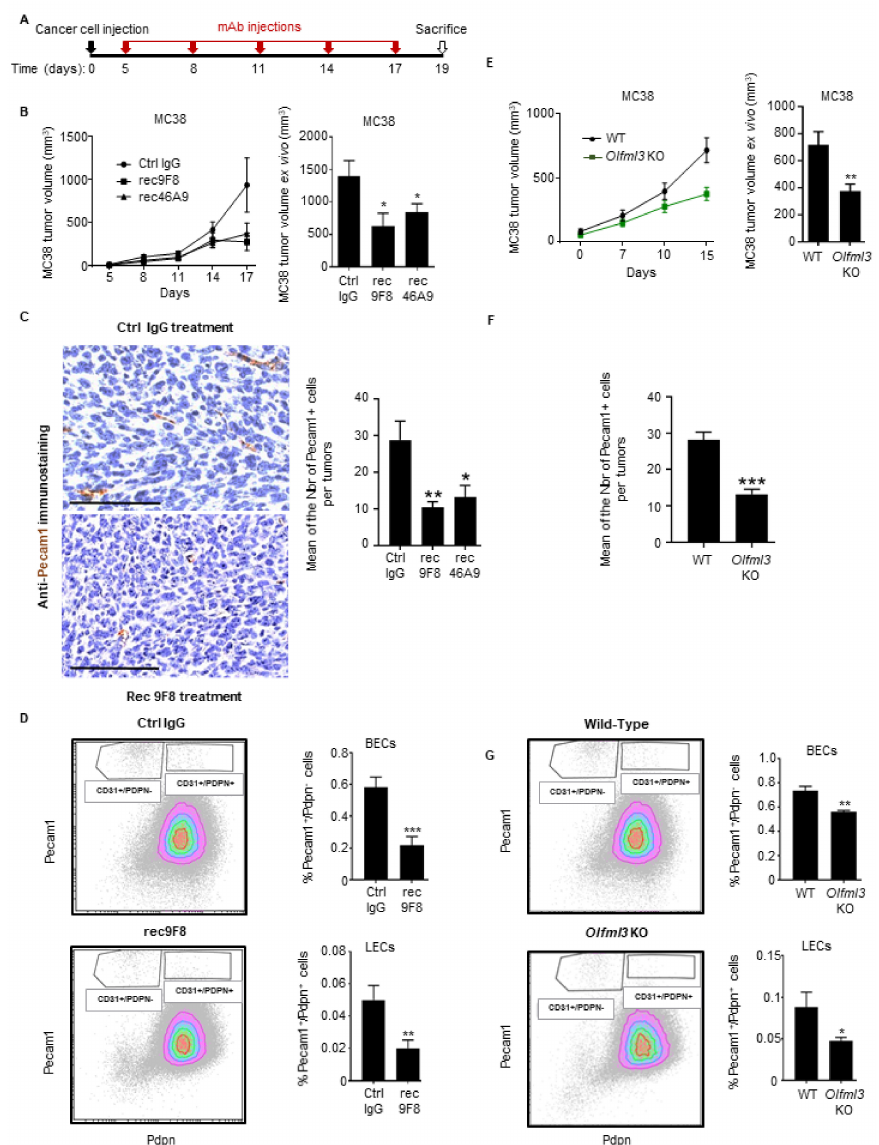
Figure 3. Expression of OLFML3 in inhibitory effects of anti-OLFML3 mAbs and Olfml3 gene deletion on CRC tumor growth and vascularization. ( A ) C57Bl6/J mice received a subcutaneous implant of MC38 tumor cells, followed by treatment with anti-OLFML3 or isotype control mAbs on days 0, 5, 8, 11, 14, and 17. ( B ) The volume of MC38 tumors in mice treated with rec9F8 ( n = 7), rec46A9 ( n = 7), or IgG2a isotype control mAb (Ctrl IgG, n = 8) was measured every 2–4 days (starting on day 3) using a caliper ( left ) or ex vivo after sacrifice on day 19 ( right ). Bars ( right ) represent the mean ± SEM; * p < 0.05. ( C ) Right, representative images (scale bar, 100 µ m), and left, quantification of Pecam1-positive events after Pecam1 immunostaining of tumor sections from ( B ). Results represent mean values ± SEM; * p < 0.05; ** p < 0.01. ( D ) Gating strategy used for flow cytometry analysis of CD45 − /CD31 + /PDPN − vascular endothelial cells and CD45 − /CD31 + /PDPN + lymphatic endothelial cells in single-cell suspensions derived from MC38 tumors from mice treated with rec9F8 or control IgG antibodies ( left ). Quantification of vascular CD45 − /CD31 + /PDPN − (middle) and lymphatic CD45 − /CD31 + /PDPN + ( right ) endothelial cells. ( E ) Growth curve (left) and ex vivo measurement of the volume ( right ) of MC38 tumors growing in wild-type (WT) ( n = 9) or Olfml3 knockout mice ( n = 14). Bars ( right ) represent the mean ± SEM; * p < 0.01. ( F ) Quantification of Pecam1- positive events after Pecam1 immunostaining of the tumor sections ( E ). Results represent the mean value ± SEM; * p < 0.05; ** p < 0.01. ( G ) Gating strategy used for flow cytometry analysis of CD45 − /CD31 + /PDPN − vascular endothelial cells and CD45 − /CD31 + /PDPN + lymphatic endothelial cells in MC38 tumor-derived single-cell suspensions from WT and Olfml3 knockout mice ( left ). Quantification of vascular CD45 − /CD31 + /PDPN − (middle) and lymphatic CD45 − /CD31 + /PDPN + ( right ) endothelial cells. Results represent the mean value ± SEM; * p < 0.05; ** p < 0.01; *** p <